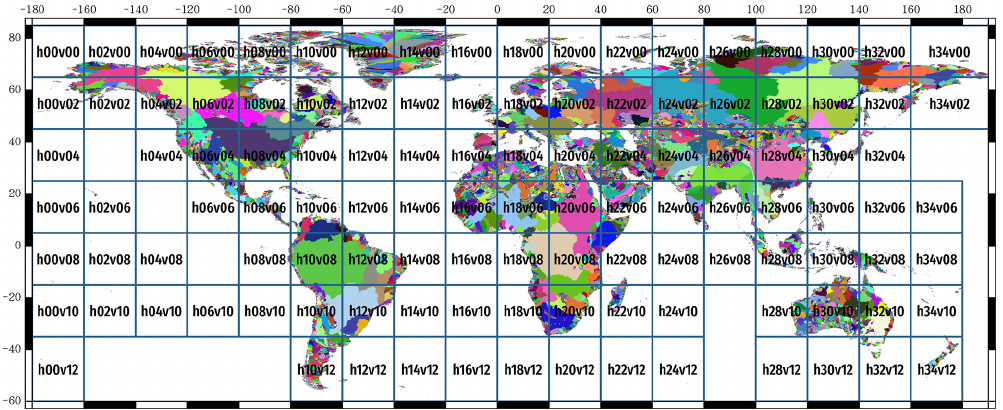
Figure 3. The regular tiling system (RTS, in blue) overlaid with global drainage basins at 3 × 3arcsec resolution (random colours for illustrative purposes). Tile labels correspond to the names of raster and vector data available for download, which are listed in Tables 1, 3, 4, 5, 6, 7. We provide an interactive map at http://hydrography.org (last access: 5 October 2022) that allows clicking on a given tile to directly download the